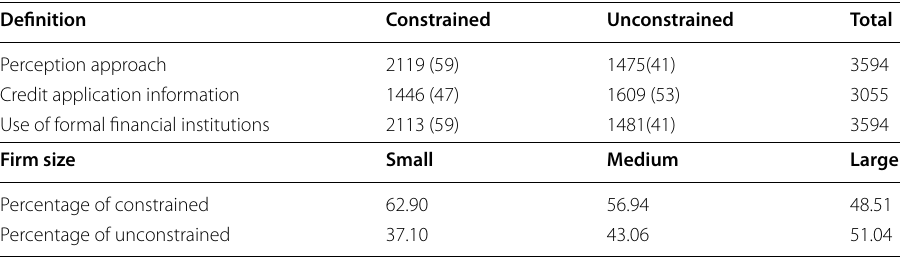
Figures in brackets are percentages. The perception approach is used to classify firms as credit‑constrained and